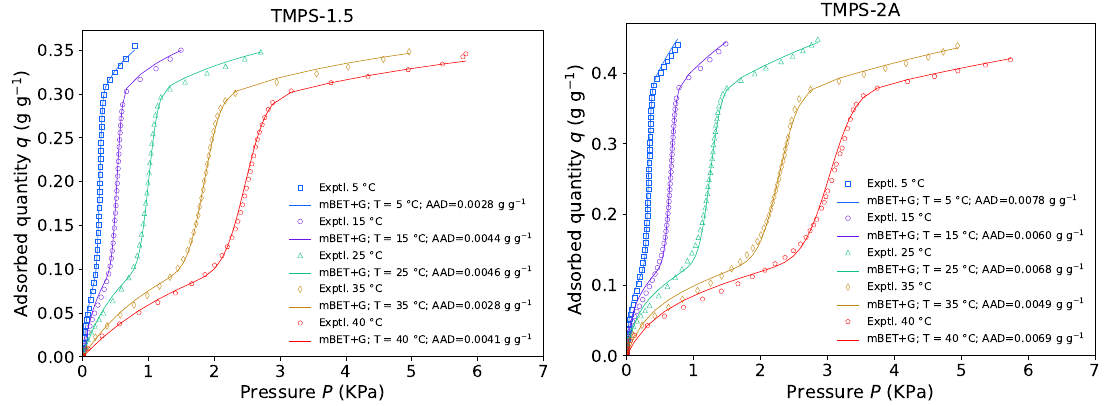
Figure 7. Fit of the mBET+G model as a function of Temperature from 5 ◦ C to 40 ◦ C for TMPS-1.5 and